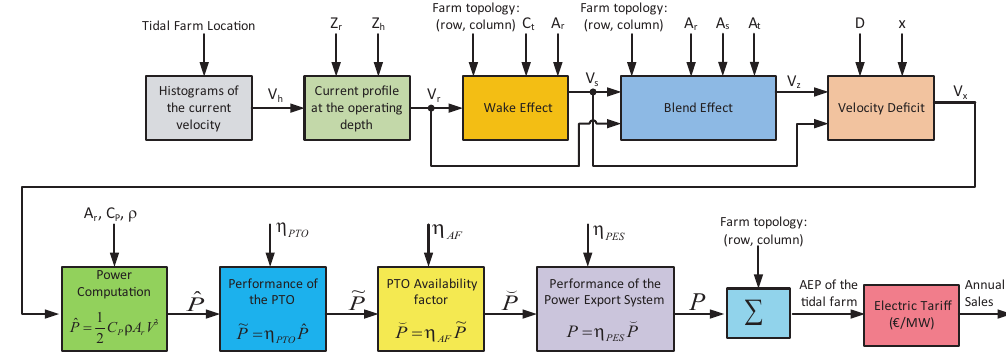
Figure 13. How annual sales are computed: A